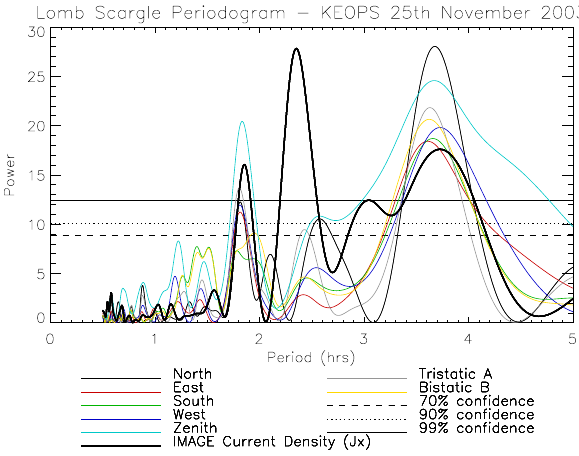
Fig. 12. The LSP for FPI intensities from KEOPS from the 25 November 2003. The periodogram for the equivalent current densi- ties from IMAGE data (thick black line) has a 200min smoothing removed, and the periodogram was divided by 4 for